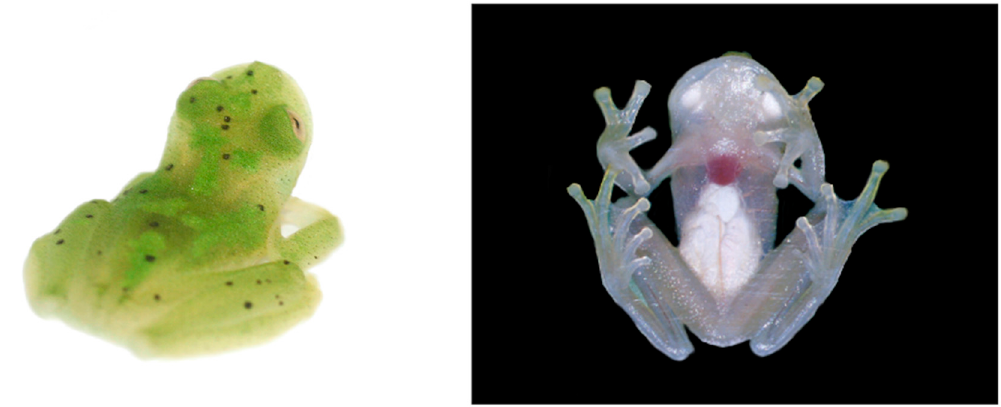
Figure 112. Hyalinobatrachium iaspidiense in life. Left: Adult female (QCAZ 38438) from Ecuador, Yachana Reserve, 300–350 m; photo by Susan North. Right: Adult male (SMNS 12247) from Guyana, Mabura Hill Forest Reserve, 60 m; photo by Raffael Ernst.